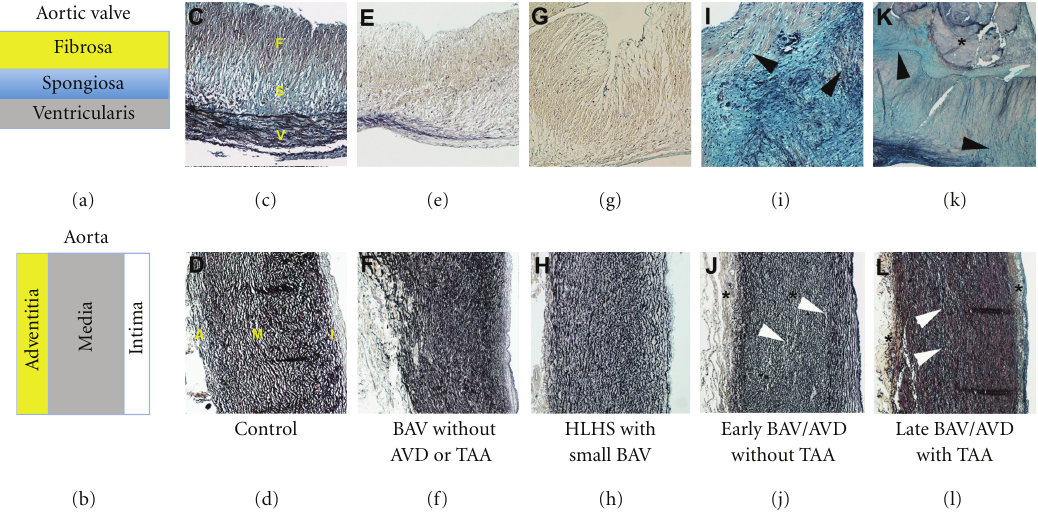
Figure 4: Cardiovascular phenotypes related to malformations of the aortic valve and thoracic aorta. Trilaminar ECM organization of the normal aortic valve (a,c) is characterized by cusps organized into Fibrosa (F), Spongiosa (S), and Ventricularis (V) layers, while the normal proximal aorta (B,D) is characterized by Adventitia (A), Media (M), and Intima (I) layers. Histopathology of a functional BAV, that is a malformed valve without disease, demonstrates preserved ECM organization and normal morphometrics in both the valve (e) and aorta (f). Similarly, the small bicuspid aortic valve of a patient with hypoplastic left heart syndrome, a severe form of aortic valve malformation, shows normal trilaminar ECM organization and morphometrics (g,h). However, BAV with AVD in a younger patient (I) shows ECM disorganization (black arrowheads), in both the a ff ected valve (i) and the aorta with normal dimensions (j). In an older patient with BAV-TAA, there is advanced AVD characterized by marked valve thickening, ECM disorganization (black arrowheads) and calcification (asterisk) and TAA characterized by subintimal hyperplasia, elastic fiber fragmentation, proteoglycan accumulation (white arrowheads), and adventitial fibrosis